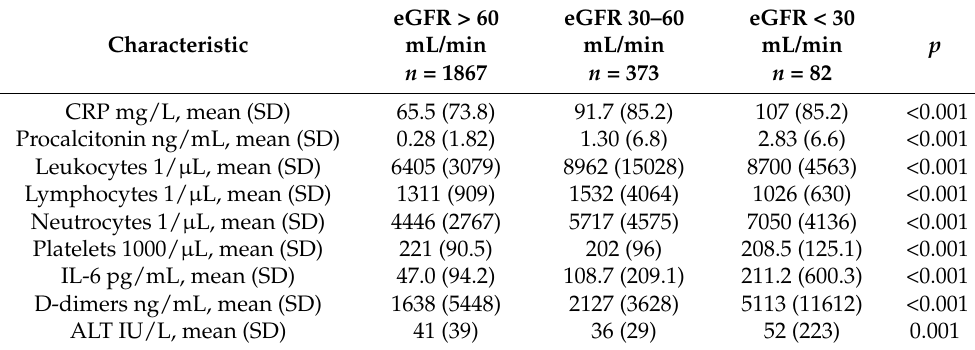
Table 2. Baseline laboratory indicators according to the baseline kidney function.